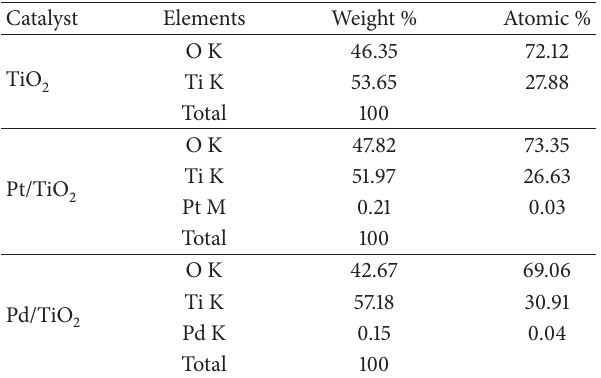
Table 1: EDX analysis of the catalysts used for photooxidation of